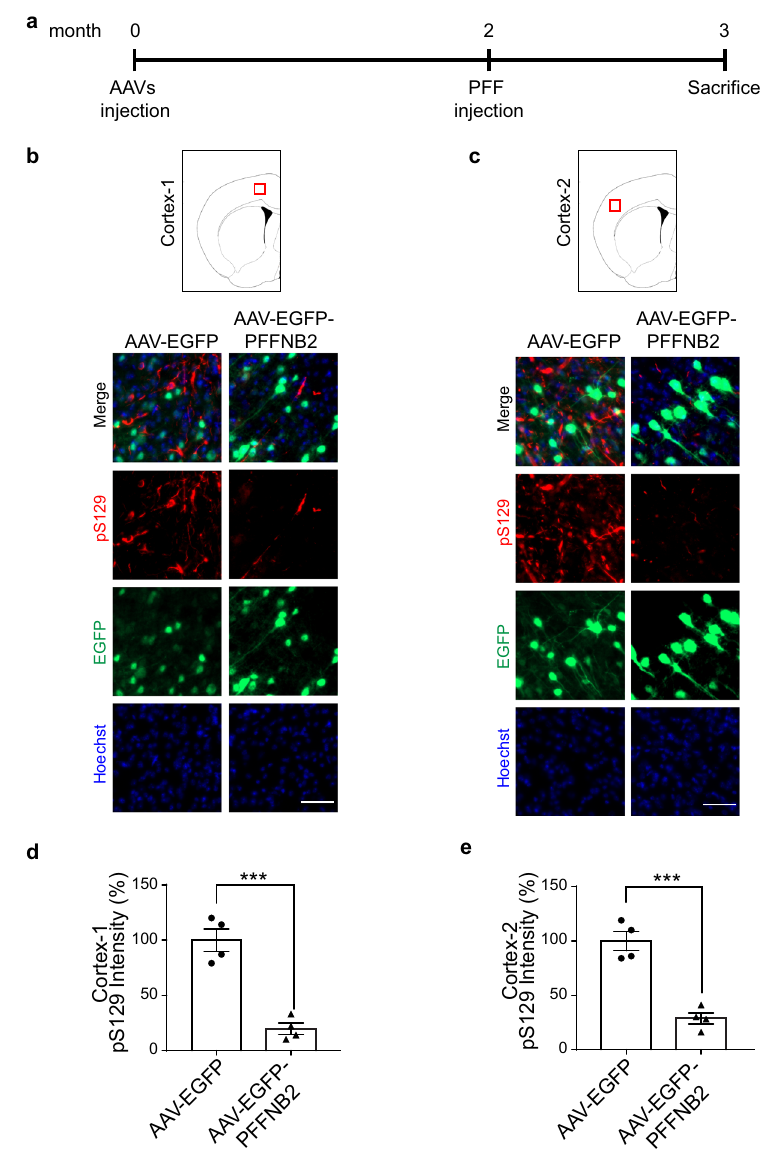
Fig. 4 AAV-EGFP-PFFNB2 reduces α -syn pathology induced by PFF in vivo. a Timeline of in vivo experiments. Intraventricular injection of AAV was performed in neonatal mouse brains. These mice were then stereotactically injected with α -syn PFF at 2-months old, and then sacri fi ced 1 month after α -syn PFF injection. b , c Immunostaining of pS129 (red) normalized by Hoechst (blue). The green signal indicates the expression level of EGFP or EGFP- PFFNB2 fusion protein in the cortex. Scale bars, 50 μ m. d , e Quanti fi cation of pS129 immunostaining in the cortex. Data are the means± SEM, n = 4 mice per group, P values were determined by two-sided Student ’ s t test. (AAV-EGFP vs. AAV-EGFP-PFFNB2, P = 0.0004). *** P < 0.001. Source data are provided as a Source Data fi